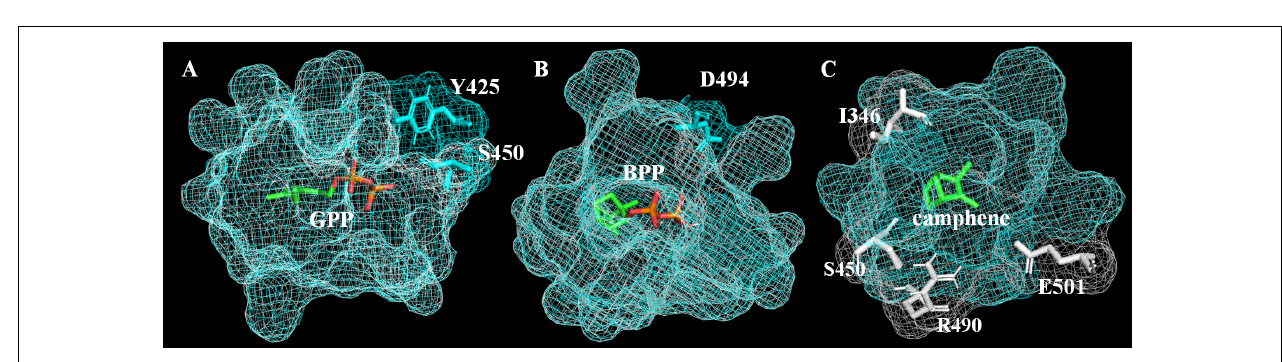
FIGURE 7 | Binding pockets of AlTPS3-A496G/AlTPS3-WT with substrate GPP (A) , product BPP (B) and product camphene (C) . Binding pockets of AlTPS3-A496G (colored in blue) is superimposed on AlTPS3-WT (colored in white). The main active and different amino acid residues are shown in sticks model, and the residues of AlTPS3-A496G and AlTPS3-WT are colored in blue and white, respectively. Substrate and products are colored in green and orange with the carbon atom shown in green and the phosphoric acid group shown in